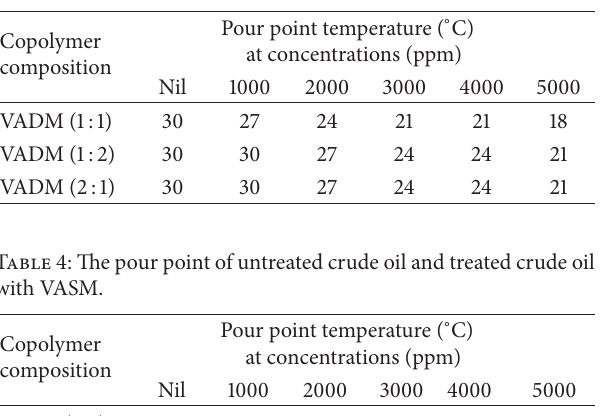
Table 3: The pour point of untreated crude oil and treated crude oil with VADM.